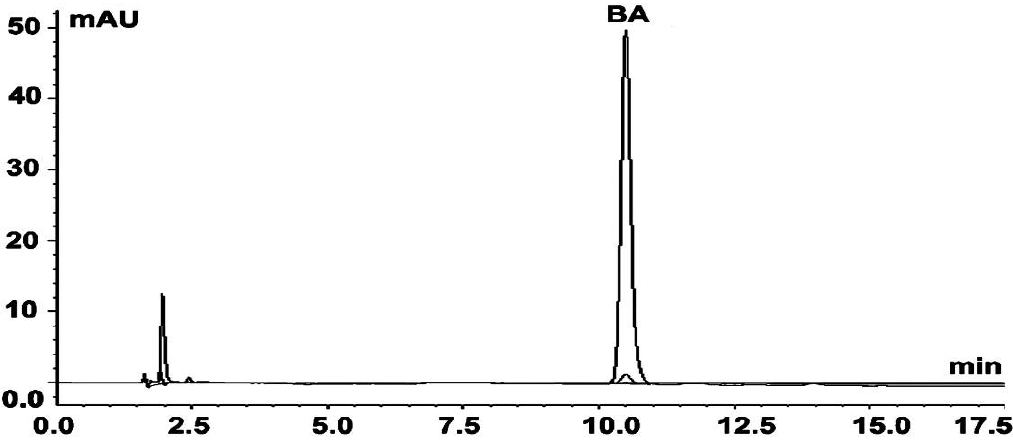
Figure 2. HPLC chromatogram of the isolated BA. Data acquisition was performed at 210, 230 and 254